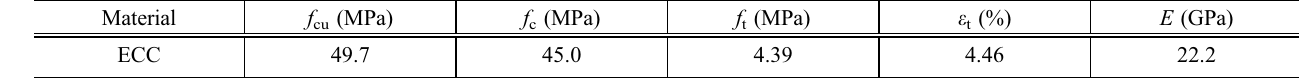
Table 5 Properties of